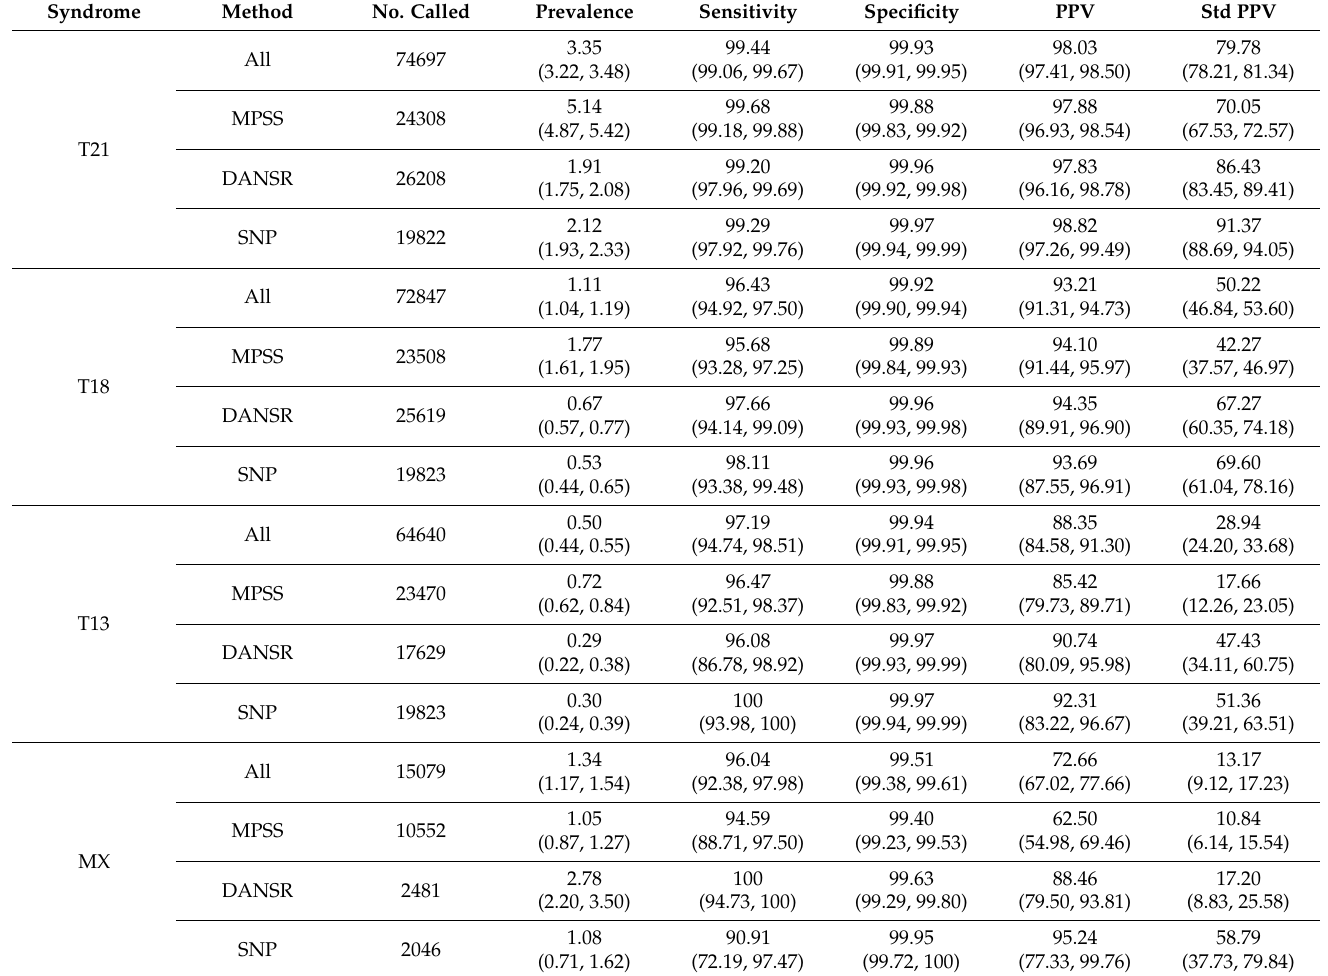
Table 1. Validation studies: pooled estimates by